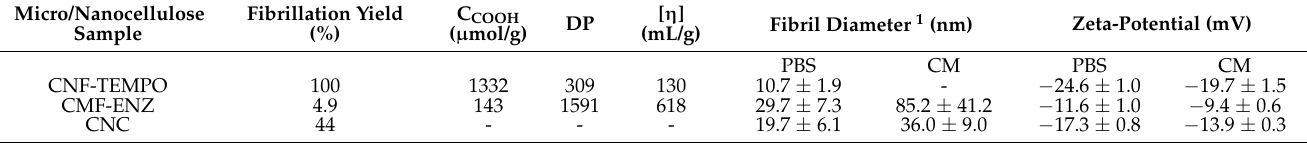
Table 2. Properties of the cellulose micro/nanomaterials under study. Micro/Nanocellulose